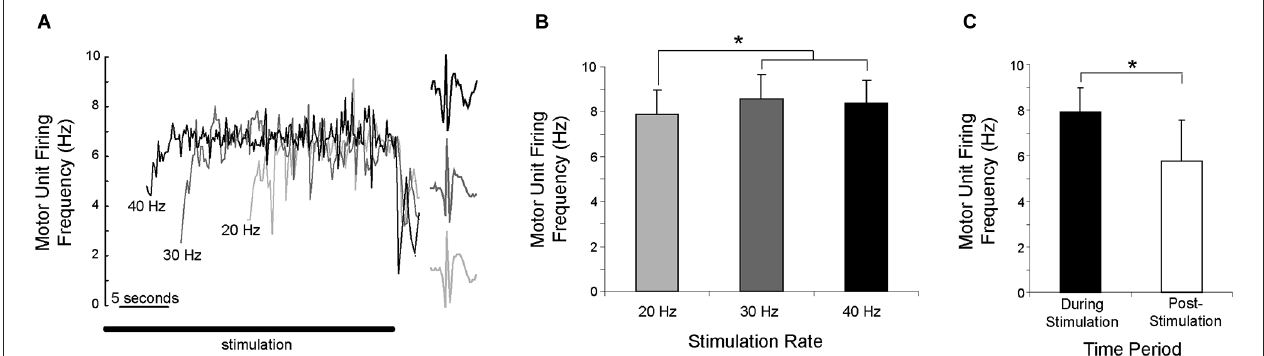
rate was significantly ( ∗ p < 0.05) lower during 20 Hz stimulation than during 30 or 40 Hz stimulation. (C) Averaged across subjects and stimulation frequency, motor unit discharge rate during the first second of sustained firing was significantly ( ∗ p < 0.05) lower than the discharge rate during the last second of stimulation.